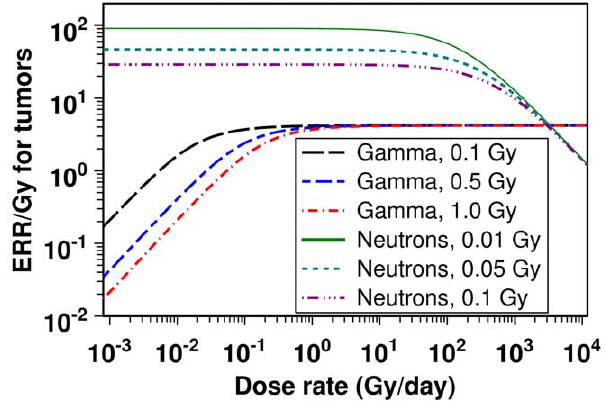
Figure 2. Model predictions for tumor ERR/Gy as function of dose/dose rate for c -rays and neutrons.